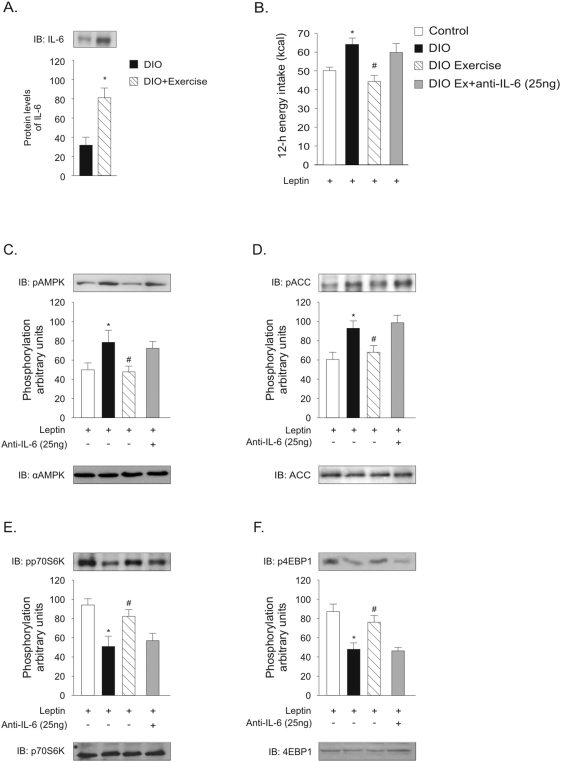
Leptin effects on 12-h cumulative food intake and AMPK/mTOR signaling in the hypothalami of control, DIO and exercised DIO rats.(a) Representative Western blots of five independent experiments showing hypothalamic IL-6 expression in DIO Wistar rats at rest and immediately after acute exercise. (b) Leptin (10−6 M) was administered in control, DIO and exercised DIO rats. Animals were immediately exposed to food for a 12-hour period (n = 12–15 animals per group). (c, d, e and f) Representative Western blots of five independent experiments showing hypothalamic lysates from Wistar rats. Phospho-AMPKthr172, threonine-phosphorylated AMPK and total AMPK (c); phospho-ACCser79, serine phosphorylated ACC and total ACC (d); phospho-p70S6Kinasethr389, threonine phosphorylated p70S6Kinase and total p70S6K (e); phospho-4EBP1thr70, threonine phosphorylated 4EBP1 and total 4EBP1 (f). Data are the means±SEM. * p<0.05, vs. control group, # p<0.05, vs. DIO group.